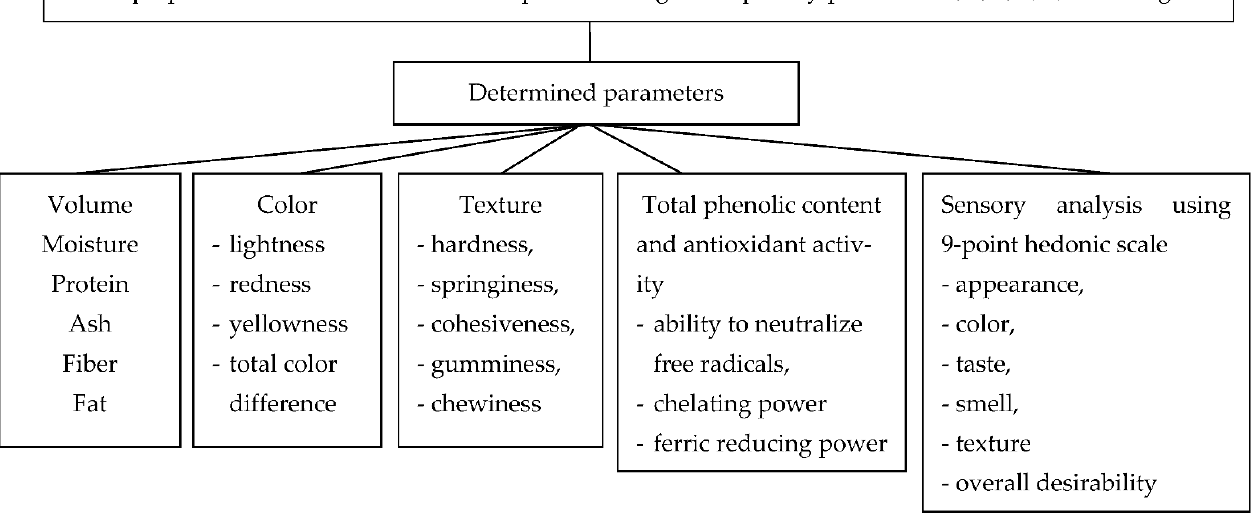
Figure 1. Properties of raw materials and bread.